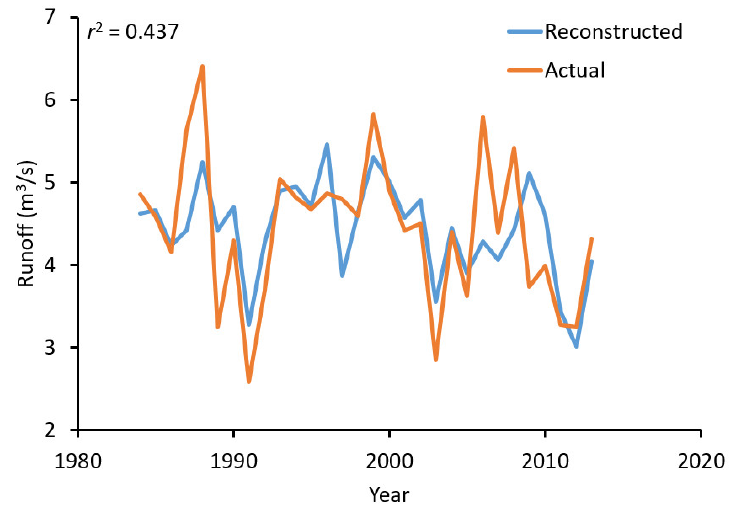
Figure 4. Comparison of the actual and reconstructed August-June runoff of the Kaiken River for the common period 1983–2013.